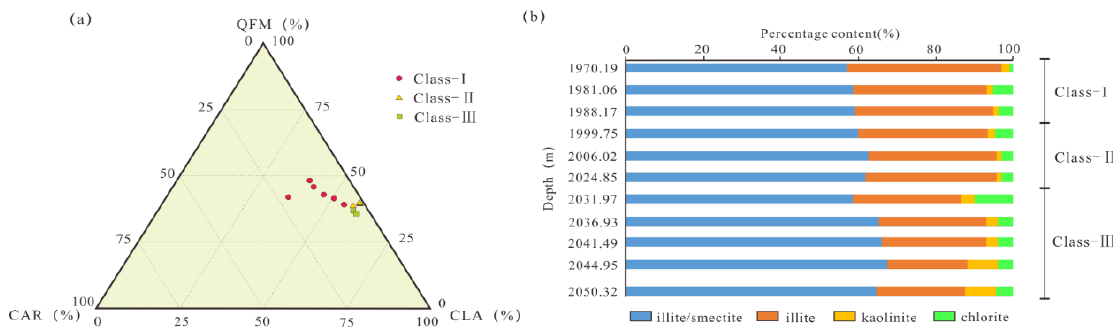
Figure 3. Mineral analysis results of samples from Da’an area, southern Songliao Basin ( a ) Triangular plot of whole rock mineral composition of samples from K2qn1 member. ( b ) Bar graph of contents of clay minerals. QFM: Brittle minerals such as quartz, feldspar, and mica; CLA: Clay minerals; CAR: Carbonate minerals.